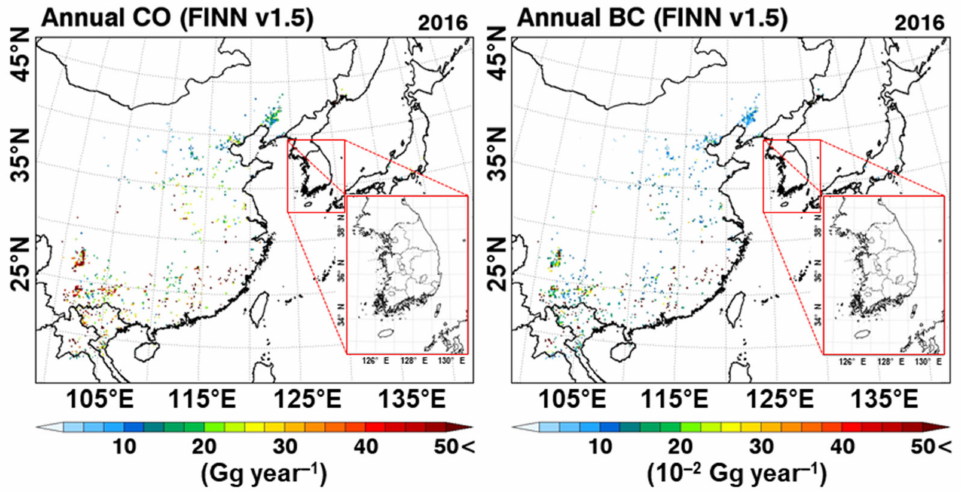
Figure 1. Annual emission fluxes of CO and BC from the FINNv1.5 inventory over East Asia. Their close-up of the area of South